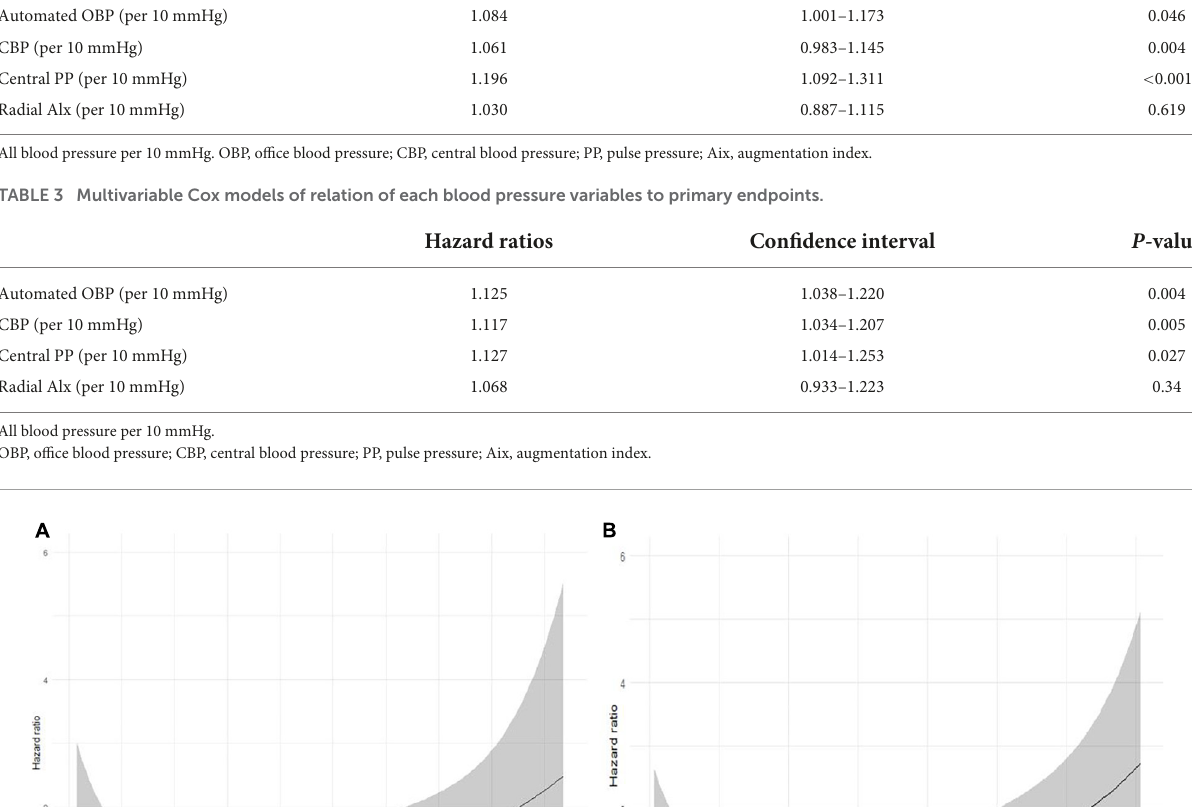
TABLE 2 Univariable Cox models of relation of each blood pressure variables to primary endpoints. Hazard ratios Confidence interval